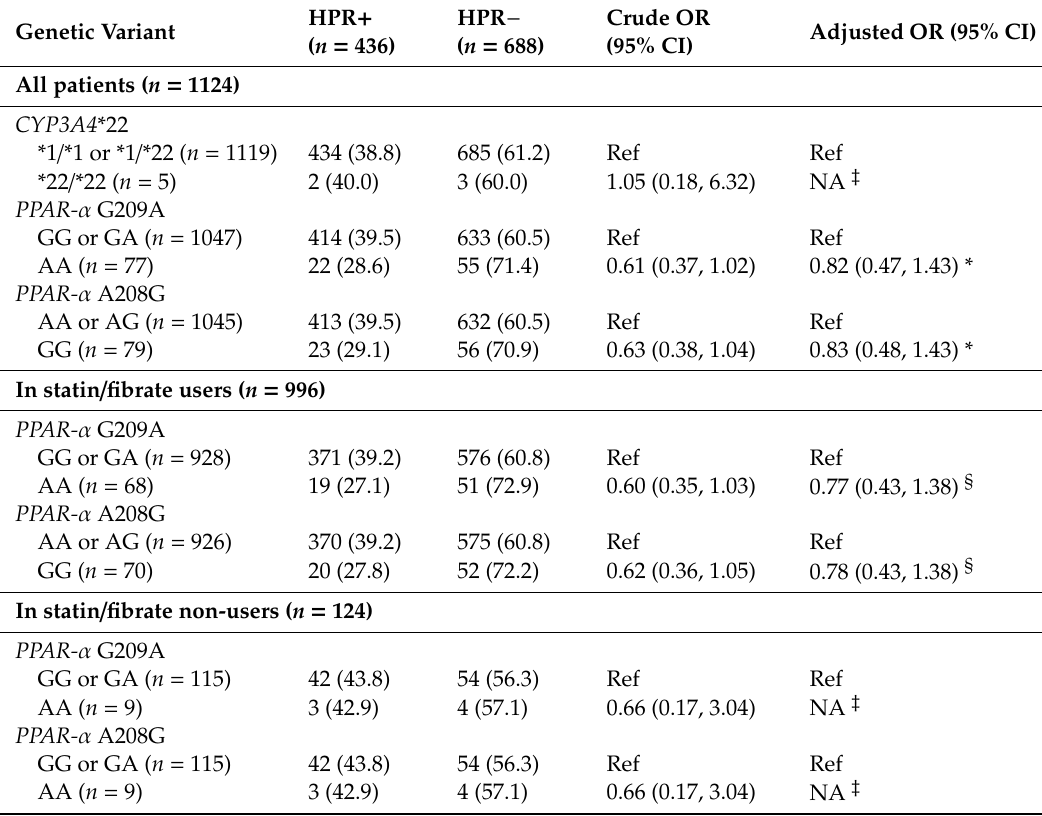
Table 3. Odds ratio for high platelet reactivity in carriers of recessive alleles of CYP3A4 *22, PPAR- α G209A, and PPAR- α A208G for the > 208 PRU cut-o ff